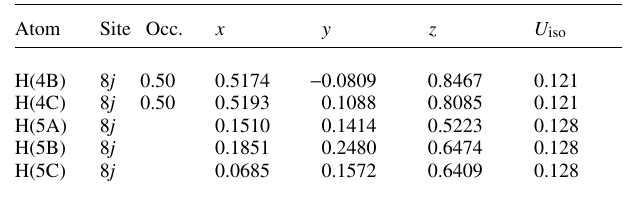
Table 2. Atomic coordinates and displacement parameters (in Å 2 )